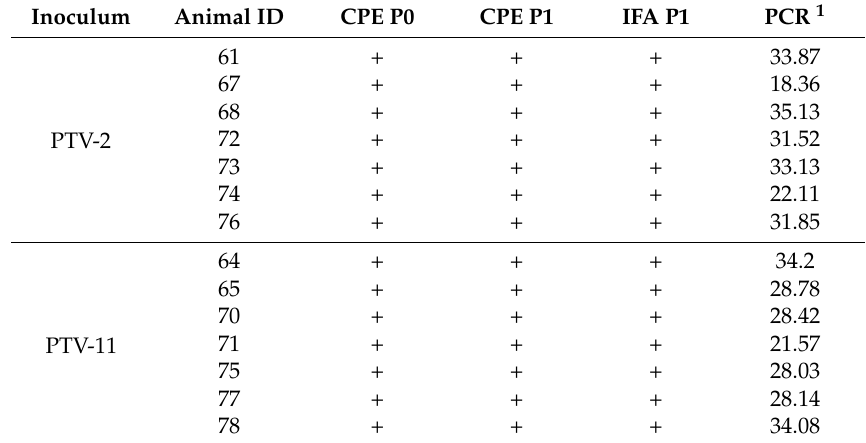
Table 7. Results of virus isolation attempts on CNS tissues from pigs inoculated with PTV-2 or PTV-11.